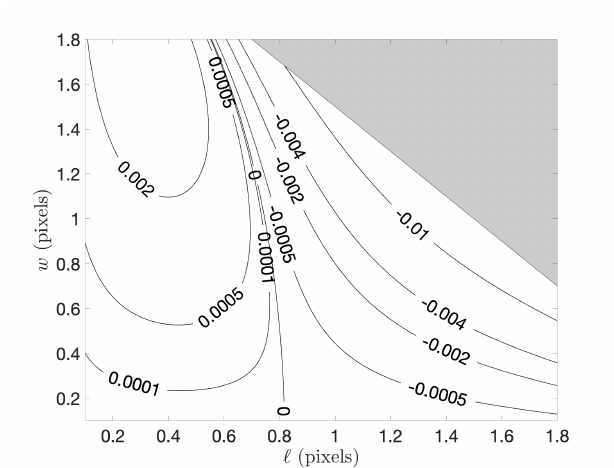
Figure 7. Contours of streak localization error when using Equation (57) for a continuous (not pixelated) wedge edge signal.